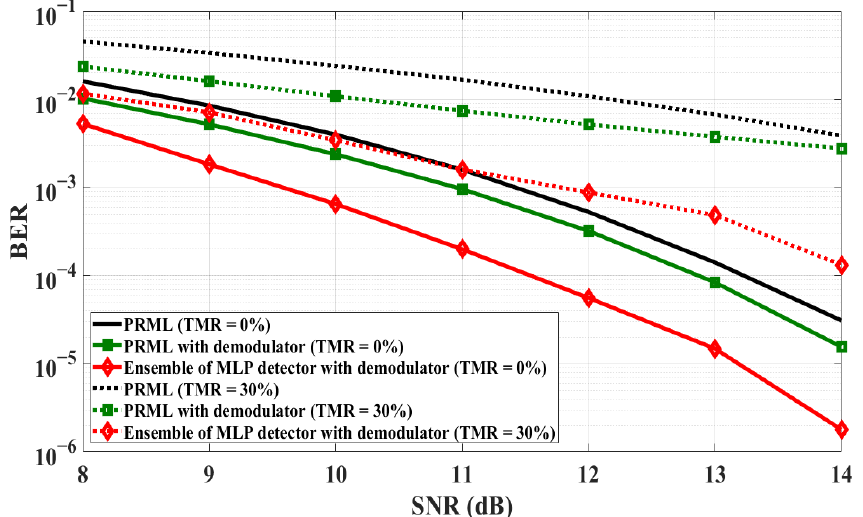
Figure 7. BER performance comparison of the models using the 4/6 modulation coding scheme at TMR of 0 and 30%.